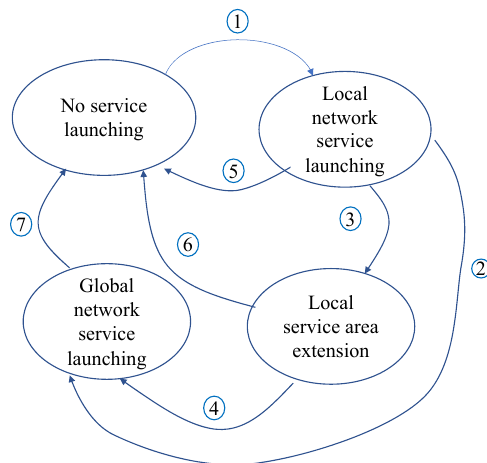
Figure 8. State machine of an LI-Cloud server.